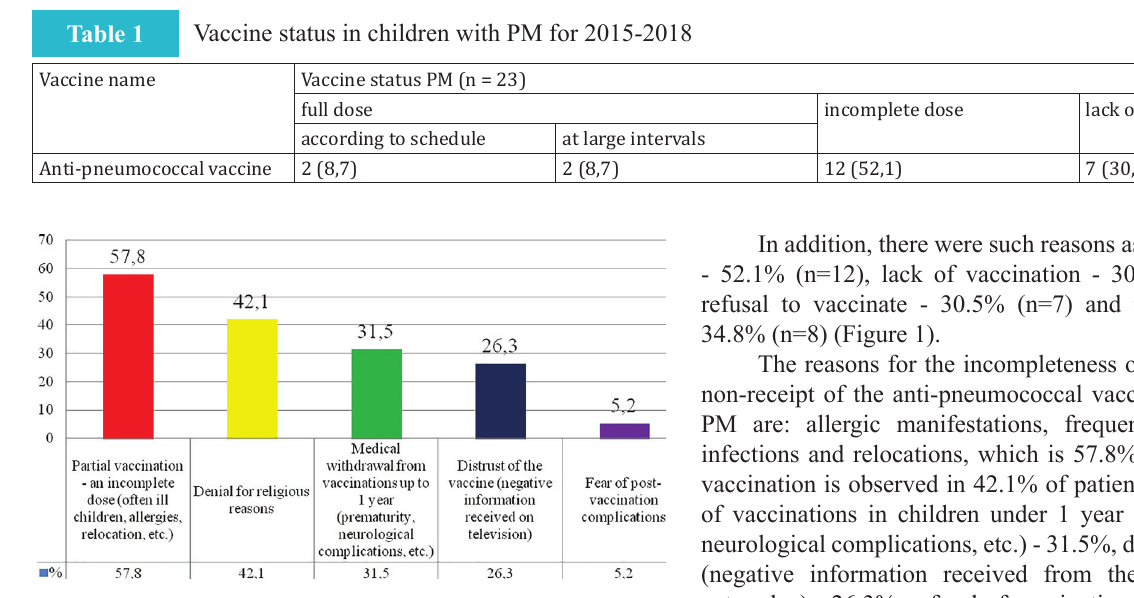
Figure 1 - Reasons for refusing vaccination with PCV 13 in patients with